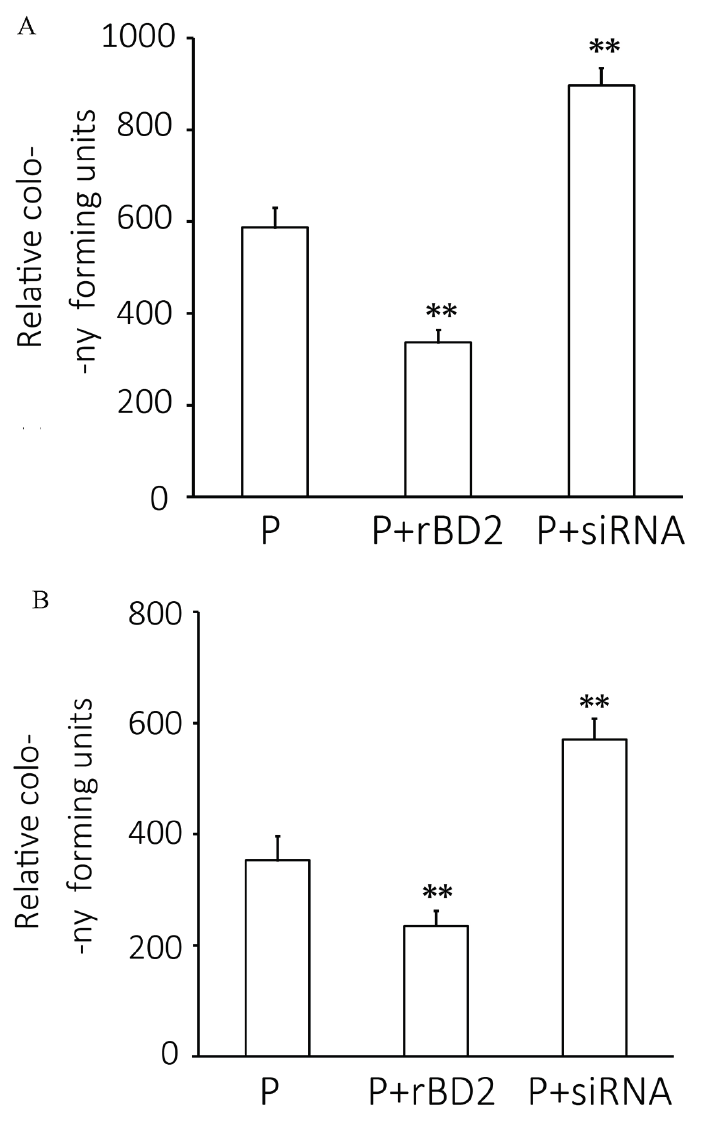
Figure 3. Counts of colony forming units (cfu) present in lung tissue homogenates ( A ) and bronchoalveolar lavage fluids (BALFs) ( B ). Data are expressed as expressed as mean ± SD ( n = 8). P, Pseudomonas aeruginosa infected group; P + rBD2 , Pseudomonas aeruginosa infected group pretreated with rBD2 expression lentivirus (P + rBD2 ); P + shRNA, Pseudomonas aeruginosa infected group pretreated with rBD2 shRNA lentivirus (P + shRNA). ** p < 0.01 versus Pseudomonas aeruginosa infected